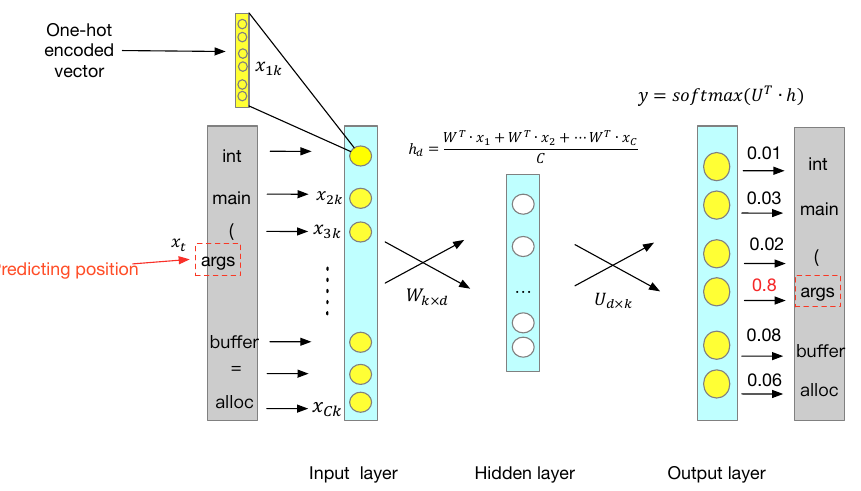
Figure 2. Overview of continuous bag-of-words (CBOW) models.